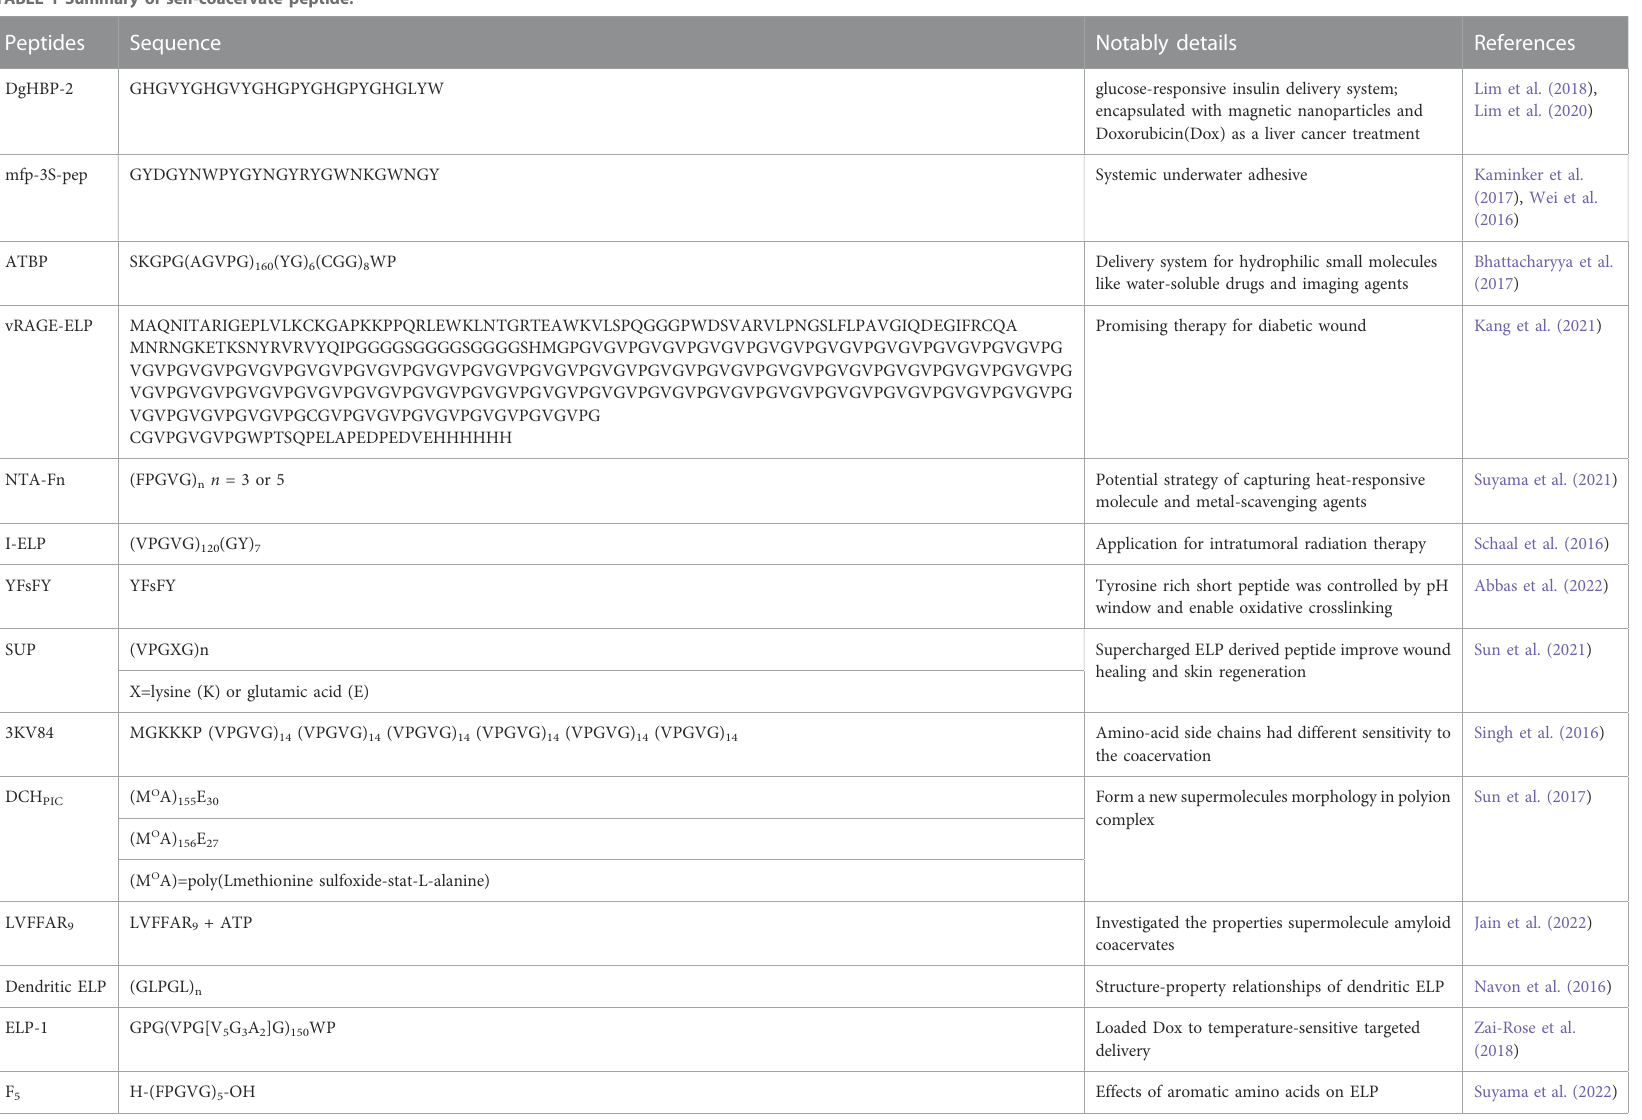
TABLE 1 Summary of self-coacervate